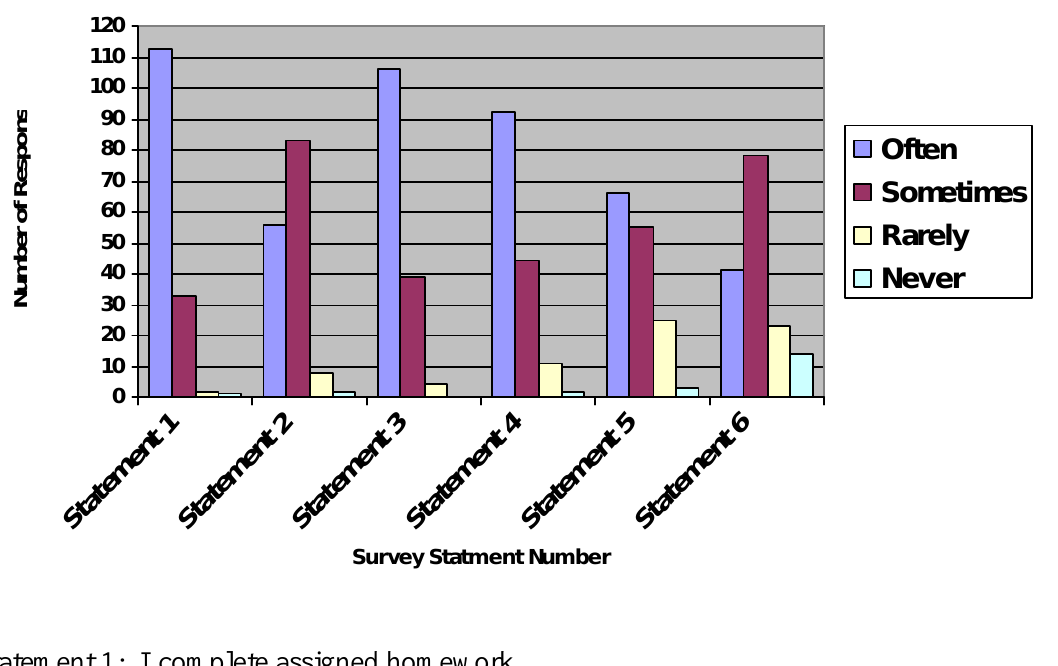
Figure 6. Student Survey after implementation of posting and communicating daily learning